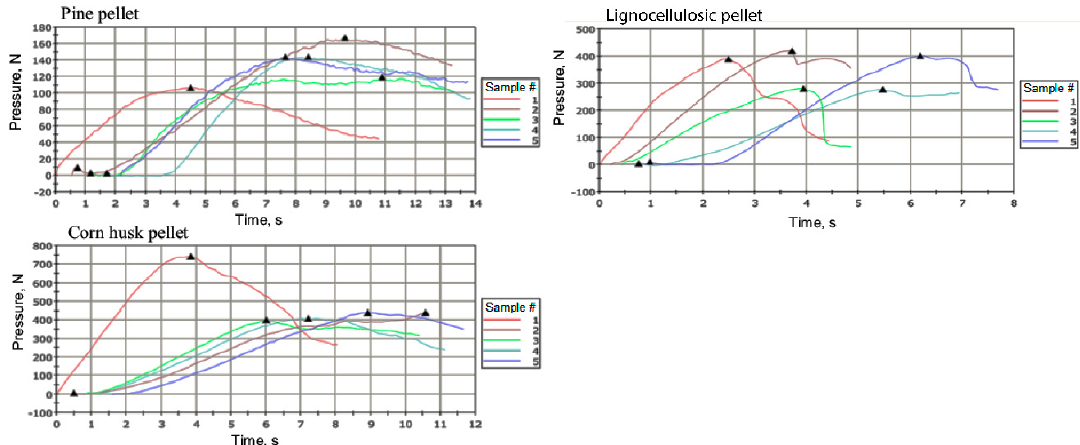
Figure 5. The response to the compressive load of pellets made of pine wood, lignocellulosic biomass, and corn husks. Black triangles signify the crack point of the pellet sample, and thus the maximum compressive strength of the densified material.